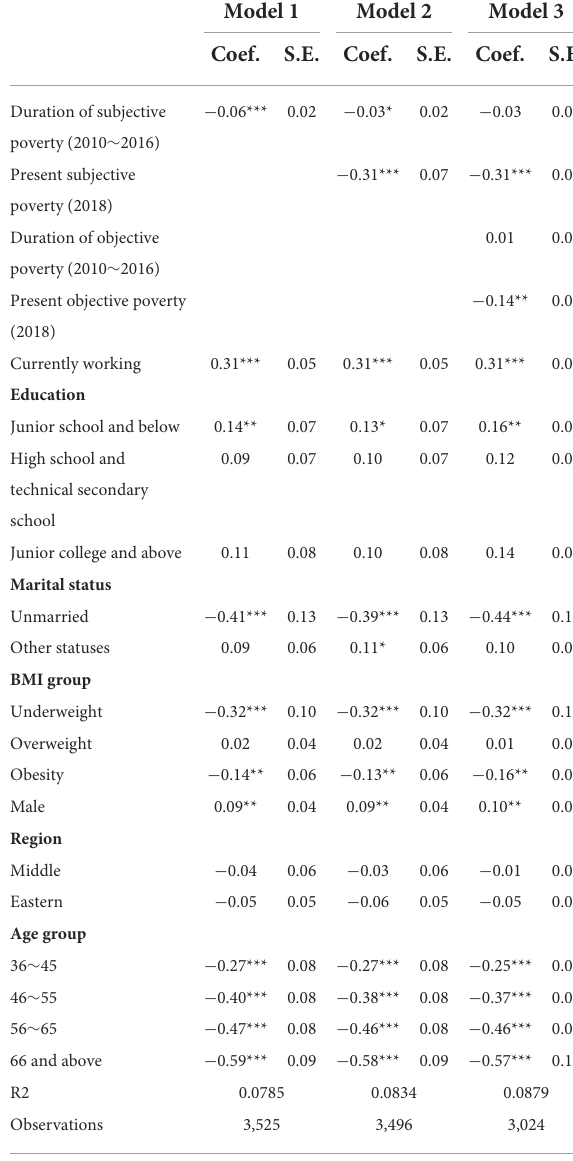
TABLE 2 Duration of subjective poverty and SRH in the total sample. TABLE 3 Duration of subjective poverty and SRH in the urban